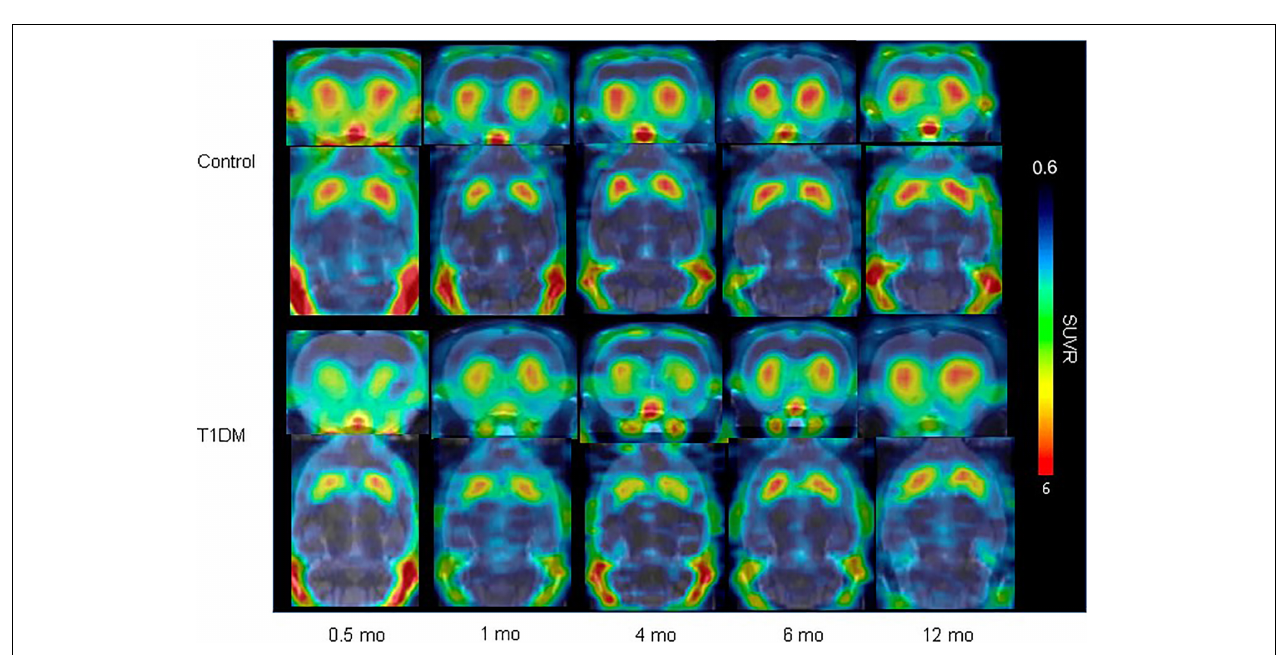
FIGURE 4 | PET imaging of the pancreas in type 1 DM (Jianfei et al., 2019) (E-produced/adapted from Chin J Endocrinol Metab, used with permission) Shown are representative 18 F-PF-(+)-DTBZ PET images of the pancreas (black arrows) of rats with type 1 diabetes mellitus (T1DM) and control rats, 0.5, 1, 4, 6, and 12 months after model induction.